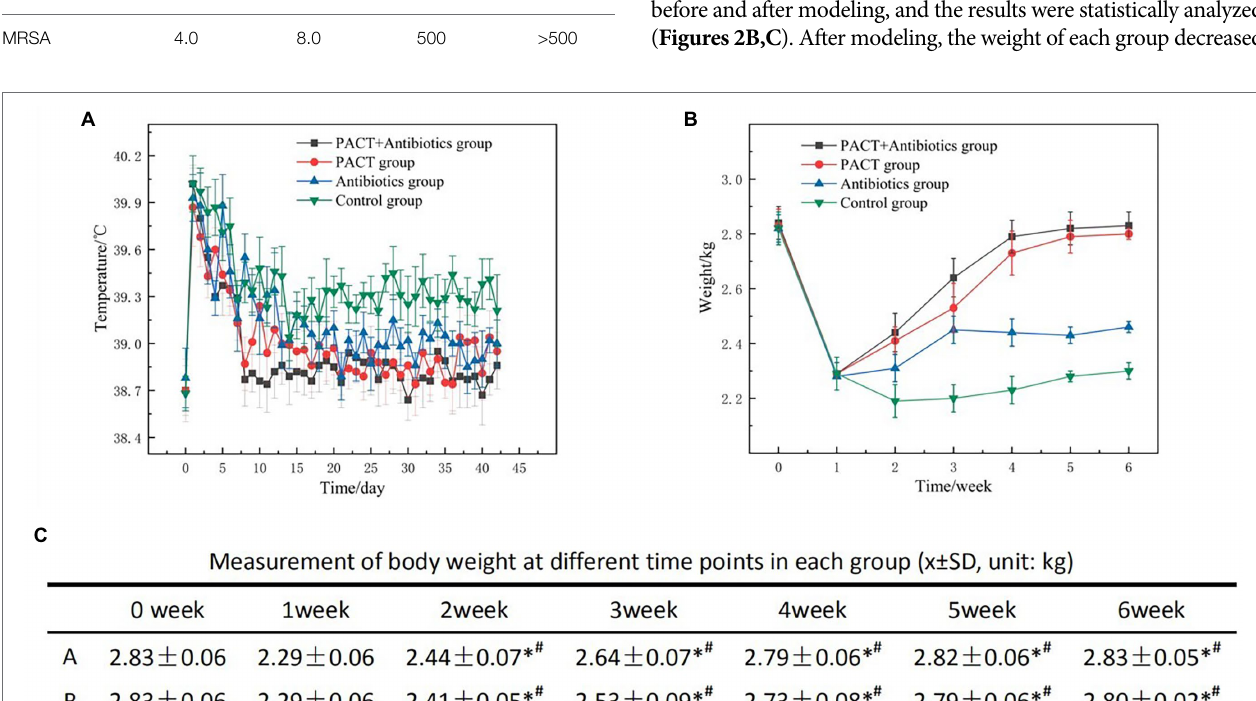
TABLE 3 | Minimum inhibitory concentration (MIC, μ M) and minimum bactericidal concentration (MBC, μ M) of methicillin-resistant Staphylococcus aureus .